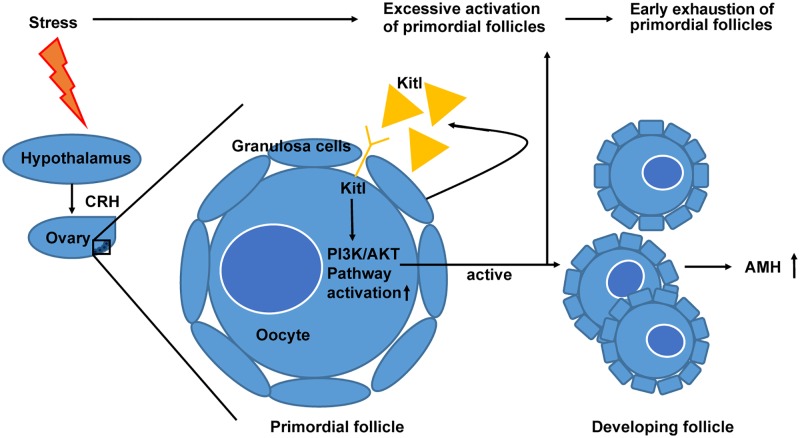
Schematic diagram showing the course of CRS inducing abnormal activation of primordial follicles.CRS leads to the excessive activation of primordial follicles, accompanied by up-regulated expression of Kitl and its receptor Kit, and the activation of PI3K/PTEN/Akt pathway. What is more, the level of serum AMH was increased significantly after CRS. CRH induced by chronic stress might play an important role in the activation and exhaustion of primordial follicles. CRS, Chronic restraint stress.